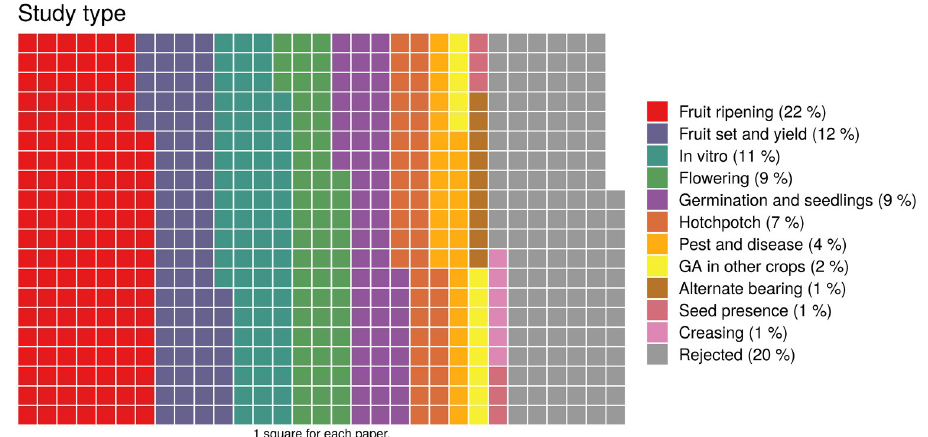
Fig 2. Classification of the 612 records in 11 groups according to the crop cycle process that GA affected.